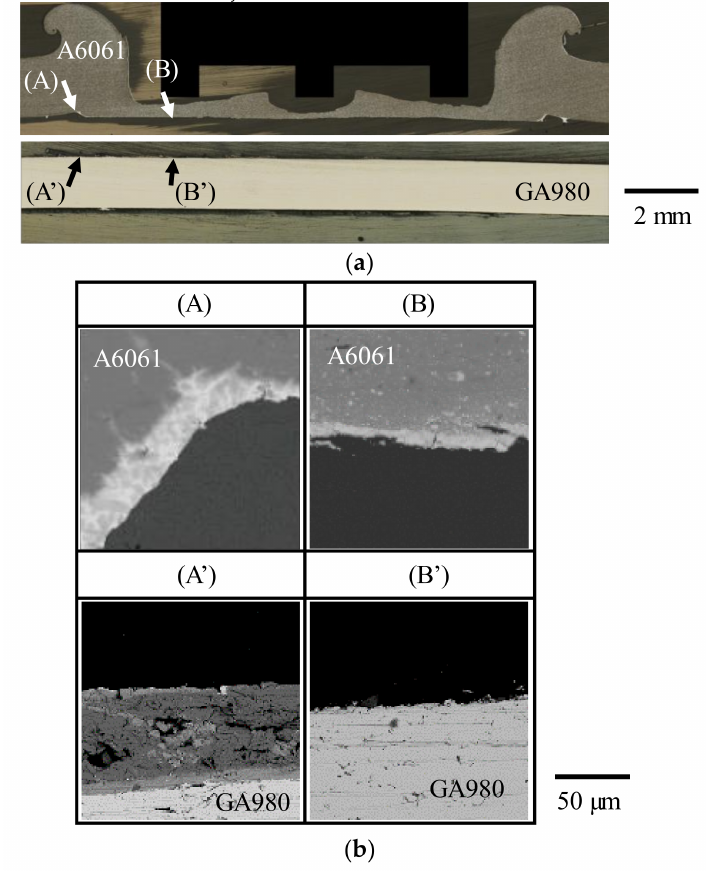
Figure 14. Cross-sectional image of the specimen ruptured by interfacial fracture in the tensile shear fatigue test (welding time: 10 s, load amplitude: 4.0 kN, number of cycles to failure: 10,165 cycles). ( a ) General view by optical microscope imaging and analyzed area by EPMA and ( b ) BSE images of the areas shown in Figure 14a observed with EPMA.